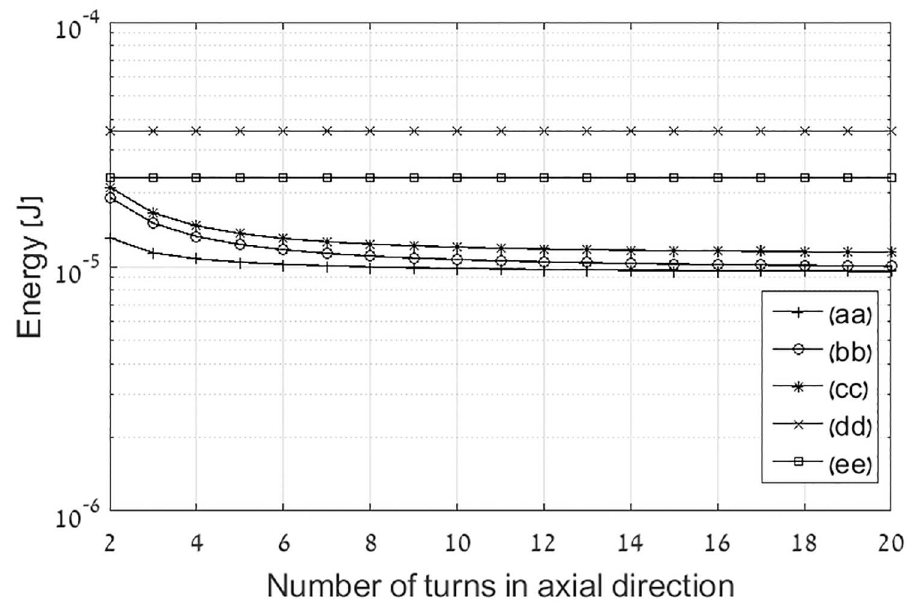
Fig 8. Energy stored at various coils topologies as function of number of turns in axial direction with constraint of constant dimensions. The energy stored in flat coils havingthe same radius are shown for reference only. Legendentries: (aa) Optimal current distribution multi-layersolenoidcoil, (bb) Optimal current distribution single layer solenoidcoil, (cc) Constant current single layer solenoidcoil, (dd) Constant current singlelayer flat coil, and (ee) Optimal current distributionspiral flat